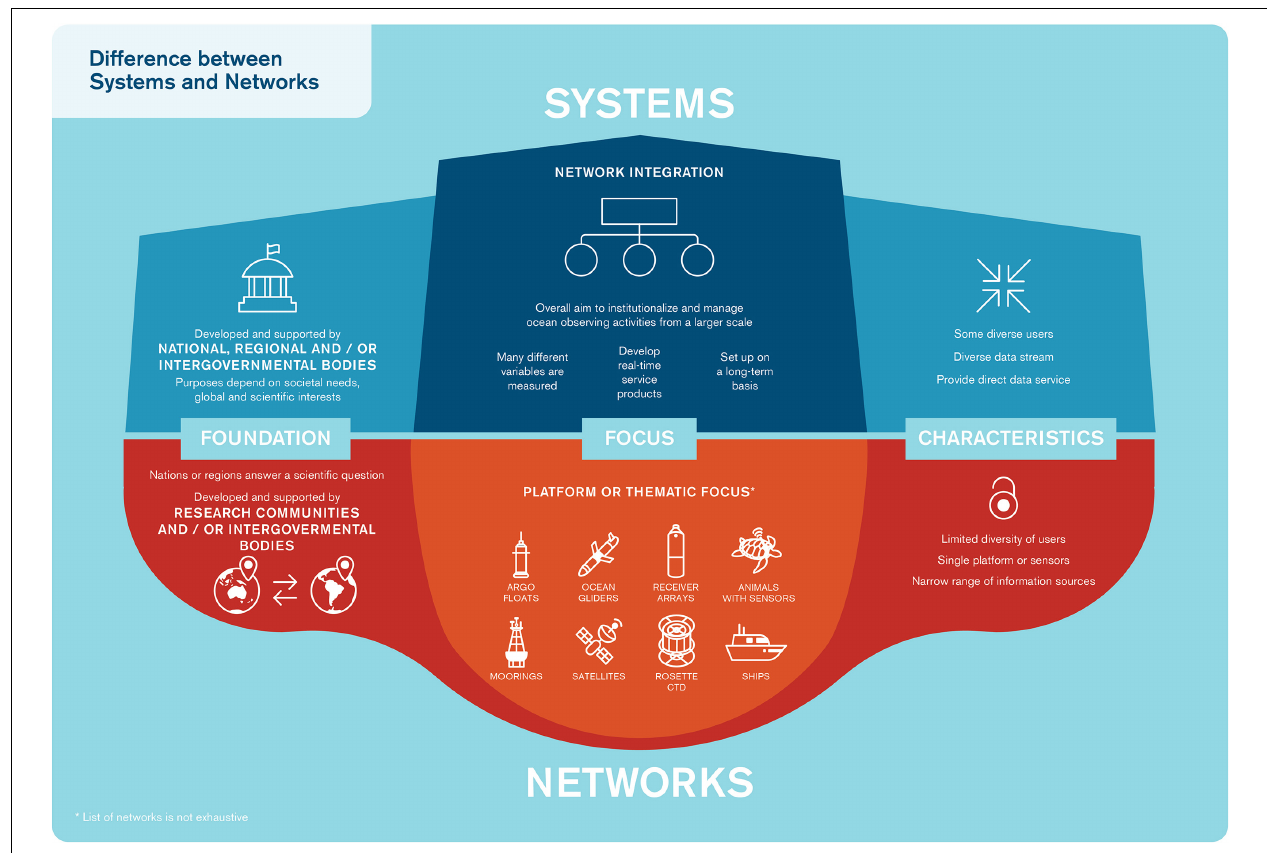
FIGURE 5 | Difference between systems and networks. Major ocean observing activities can be organized into two categories: Systems and Networks. AtlantOS, as a system, will coordinate networks conducting ocean observing in the